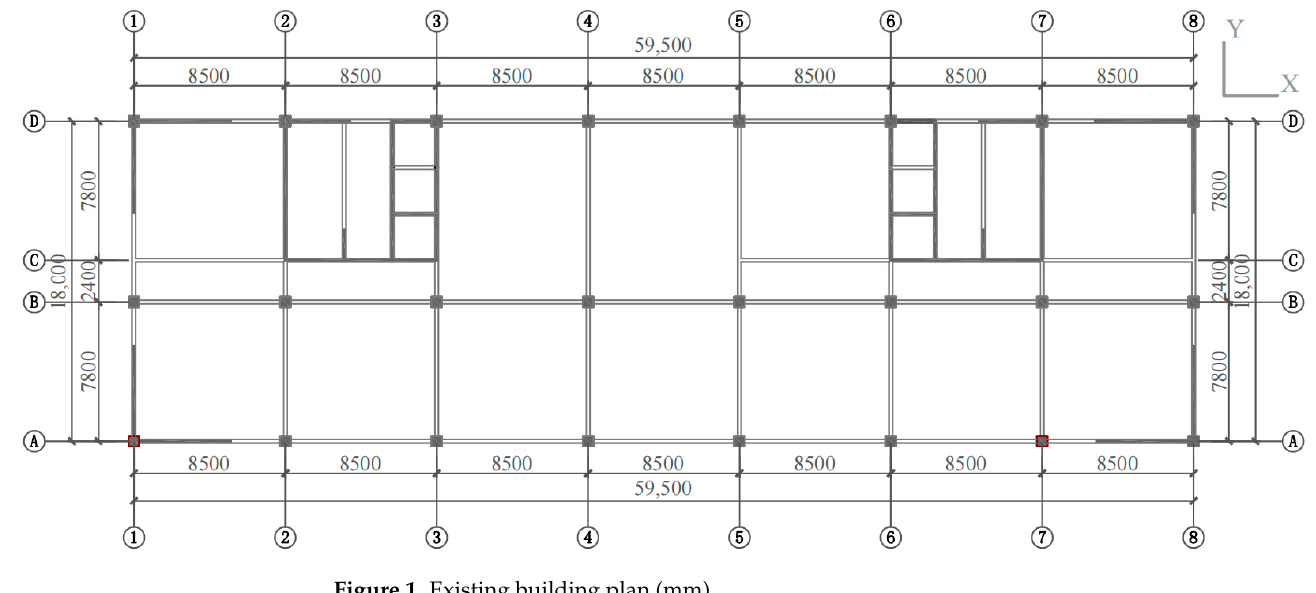
Figure 1. Existing building plan (mm).